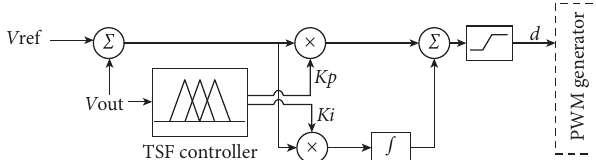
Figure 15: Diagram of the TSF-PI controller principle.